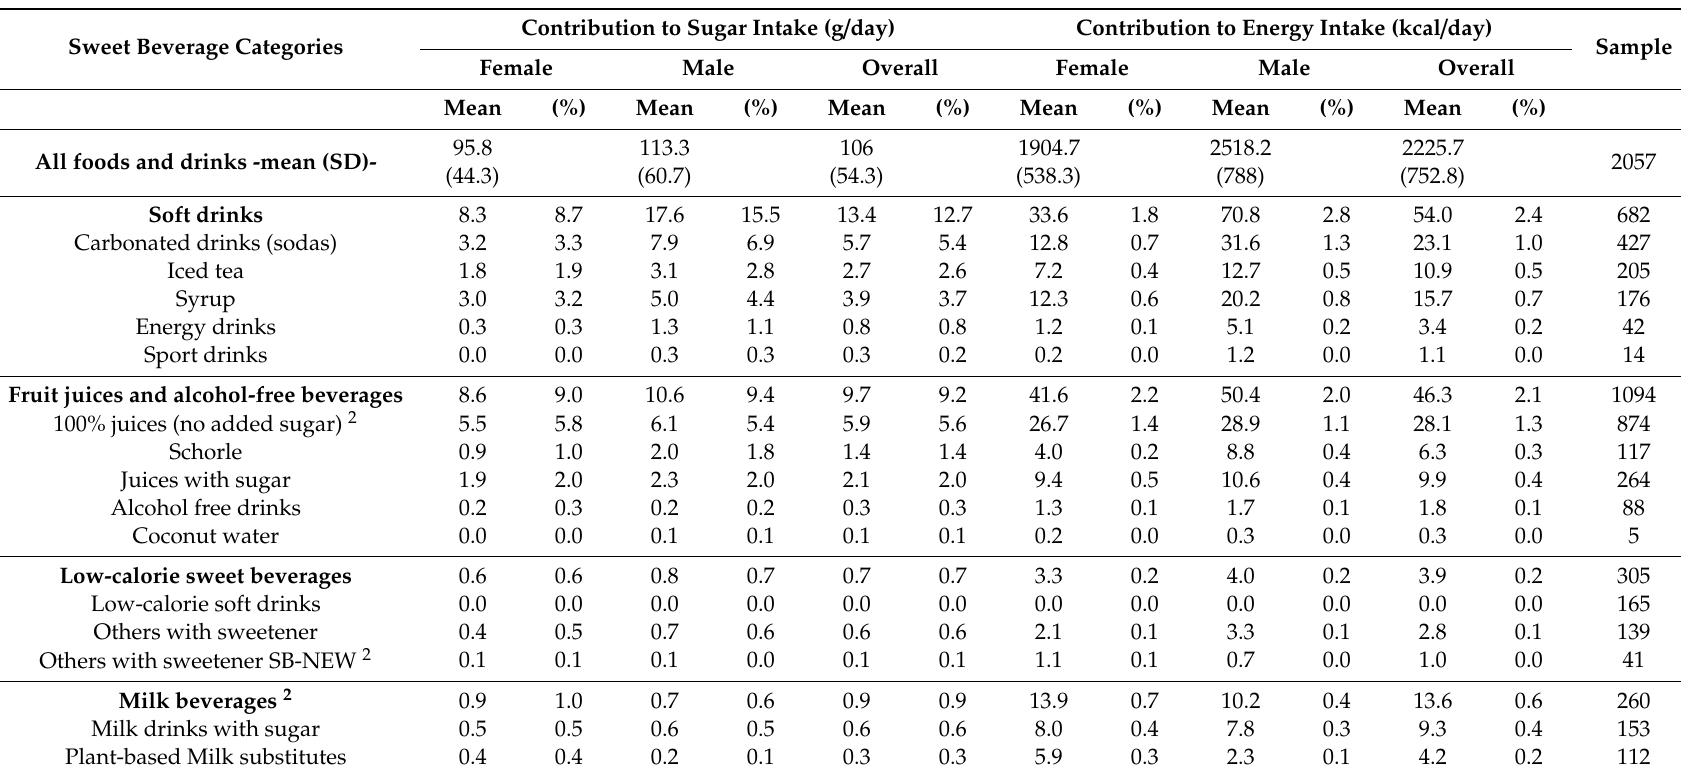
Table A3. Weighted contribution of sweet beverages to total sugar (g / day) and energy intake (kcal / day) from all foods and drinks, by